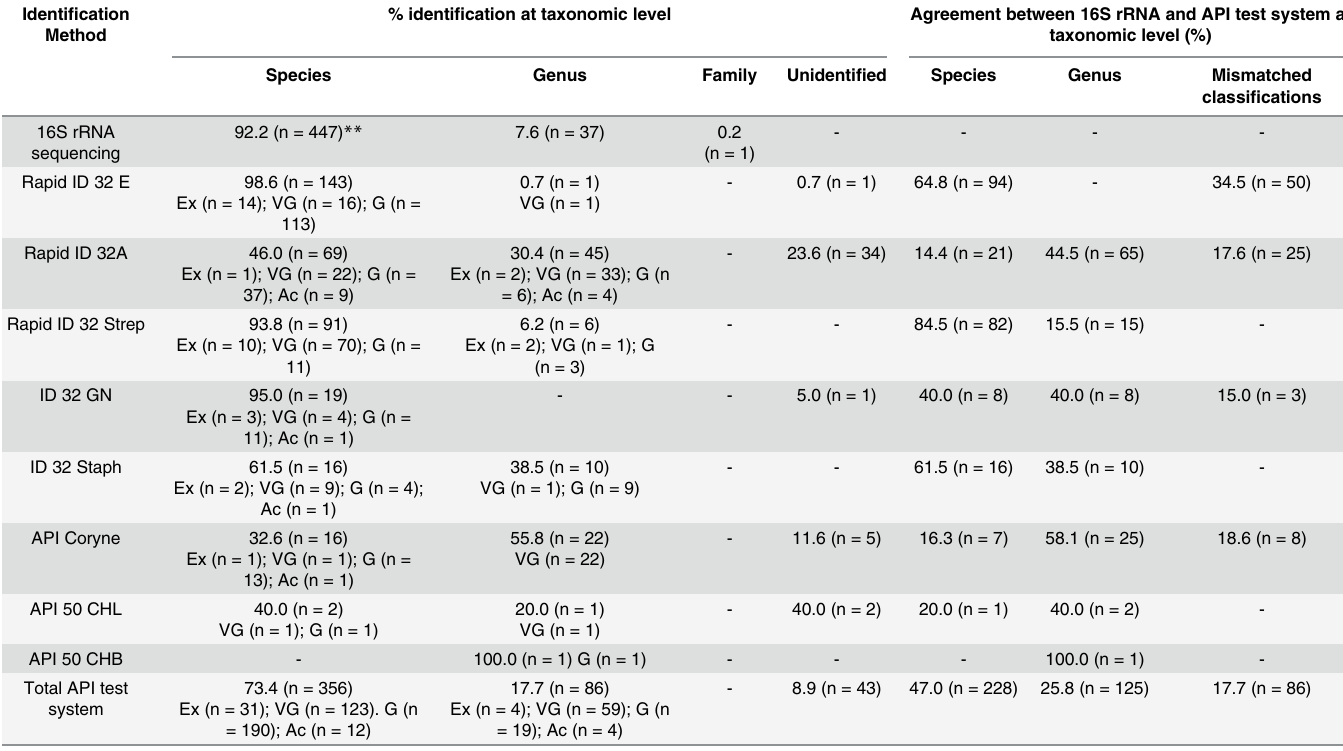
** Values in parenthesis correspond to the number of isolates and number of isolates reported with Excellent (Ex), Very Good (VG), Good (G) and Acceptable (Ac) identi fi cations using the miniAPI Analyser. Results reported as poor discrimination, unacceptable and not interpretable upon repeated testing were recorded as unidenti fi